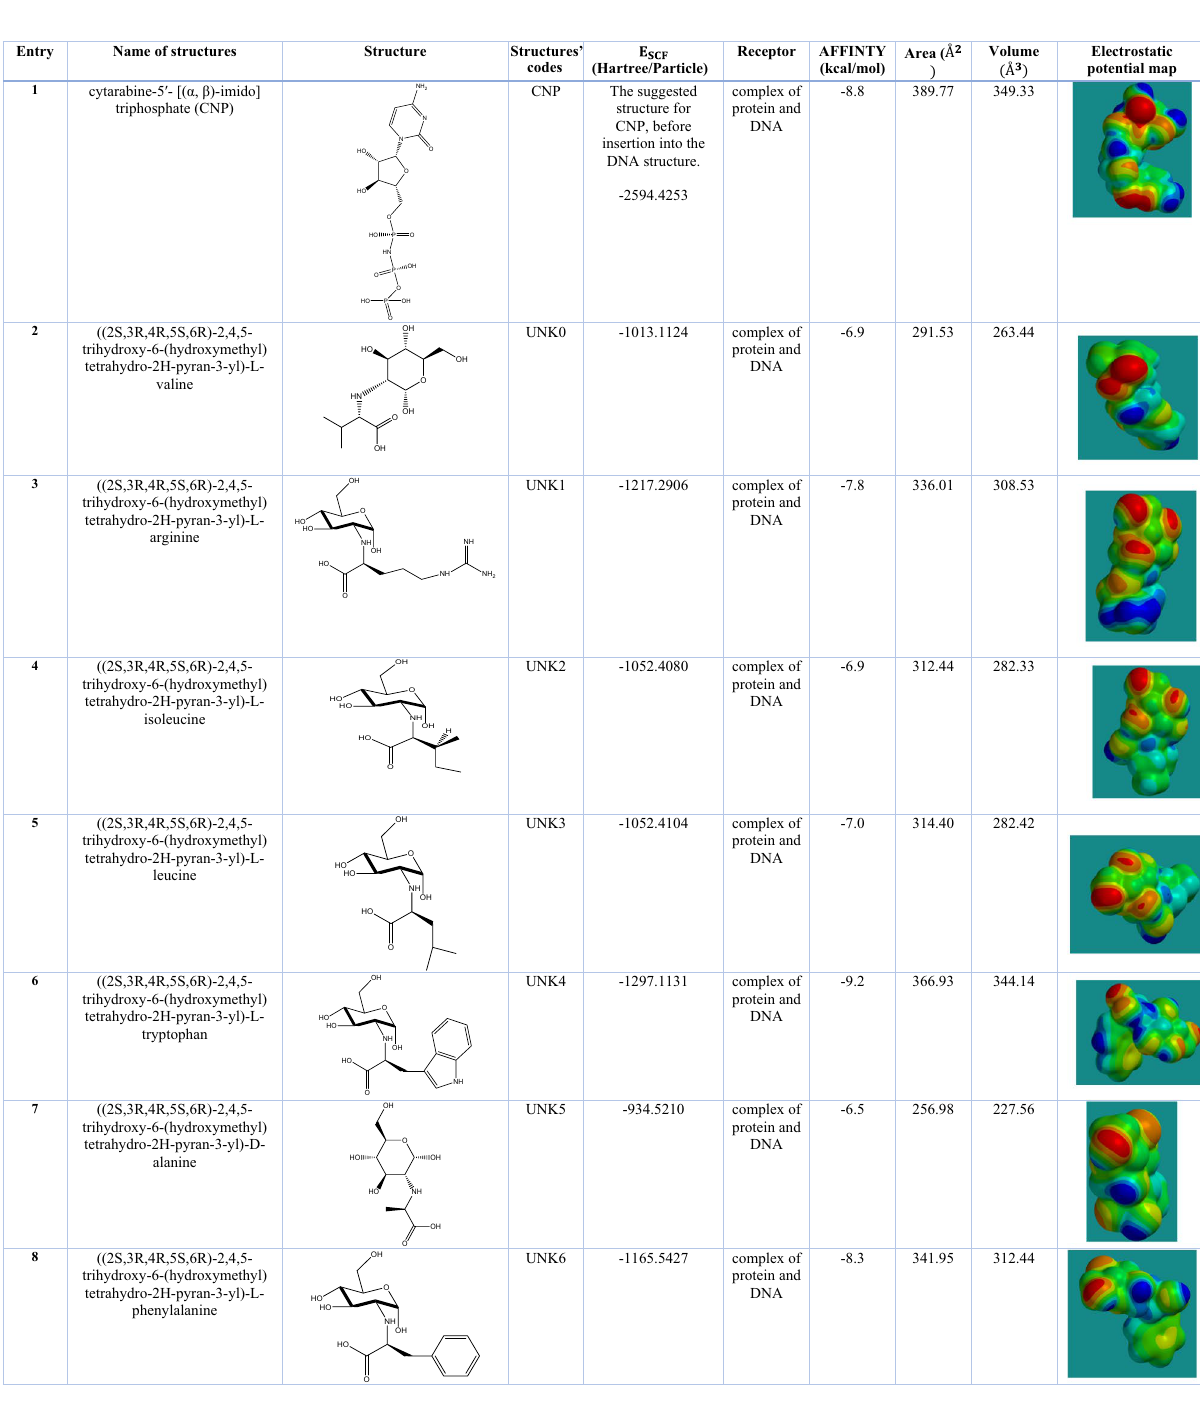
Table 1. The structural information for cytarabine-5 ′ -triphosphate and our designed amino acid-carbohydrate based